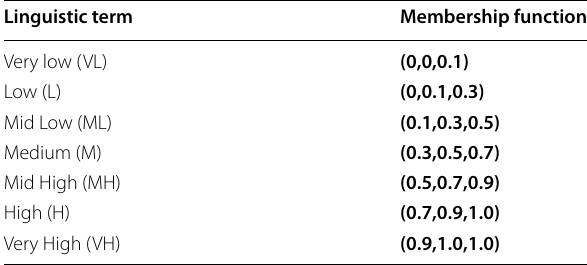
Fuzzy analytical hierarchy process (FAHP)